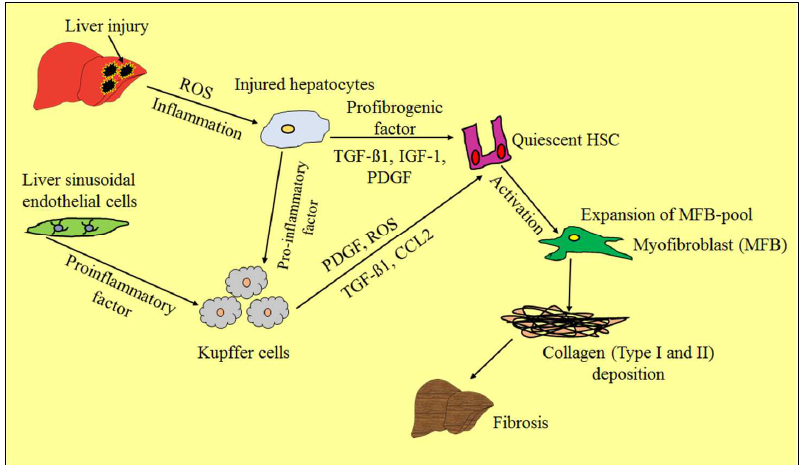
Figure 1. Schematic depiction of pathogenesis and pathophysiology during liver fibrosis progres- sion. Chronic hepatic inflammation causes activation of quiescent hepatic stellate cells, which obtains transdifferentiate into MFB-like cells, which have contractile, proinflammatory, and fibrogenic properties. MFB: myofibroblast, HSC: hepatic stellate cell, ROS: reactive oxygen species, TGF-β1: transforming growth factor-β1, PDGF: platelet-derived growth factor, and CCL2: chemokine.